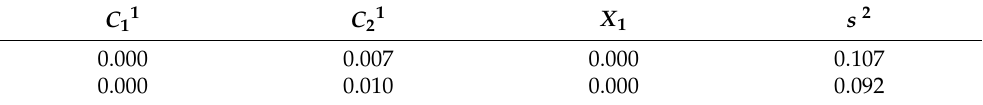
Table 4. Fraction of 5-FU species solubilized by the β -CD, s, in aqueous 5-FU ( C 1 ) + β -CD ( C 2 ) solutions at T = 298.15 K and P = 101.3 kPa.